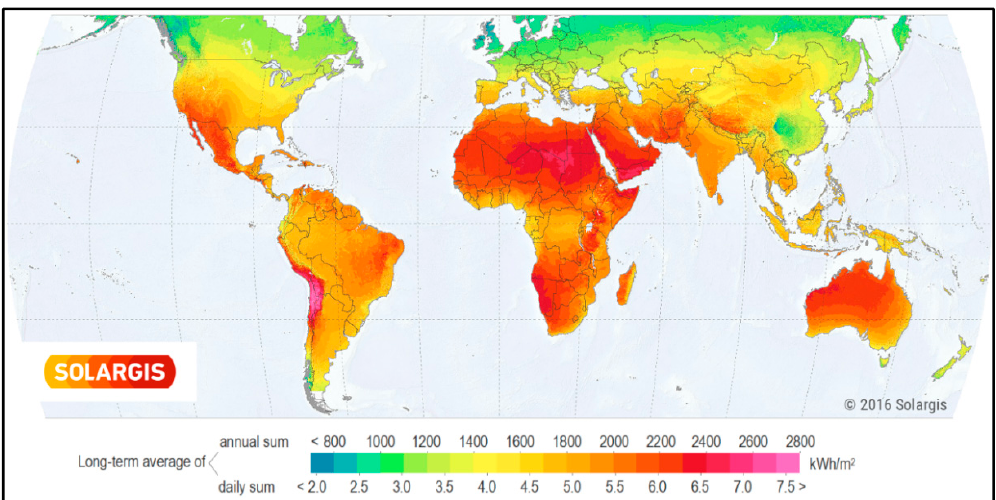
Figure 8. Global solar irradiation map [95].